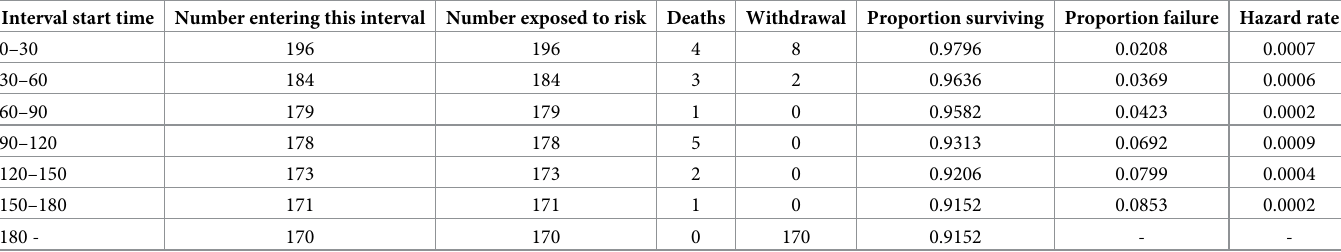
Table 3. Follow-up life table of 196 calves born in Gamo zone milk-shed districts.